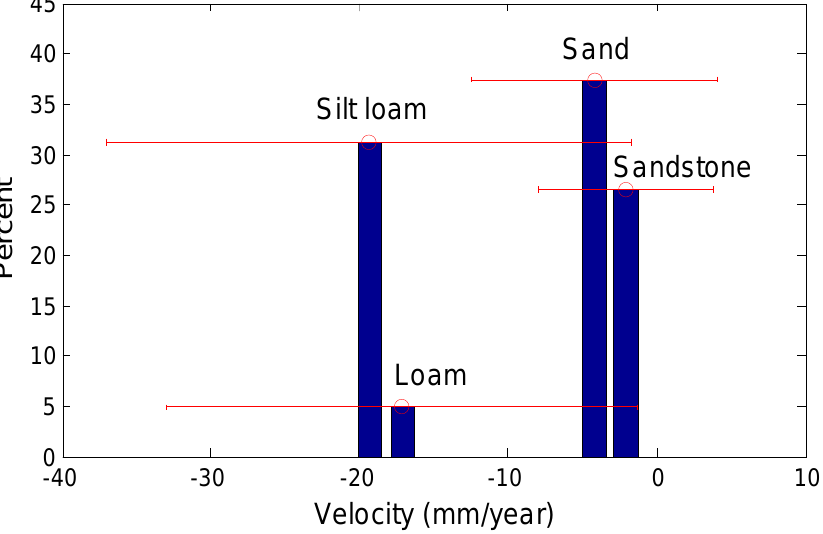
Figure 8. Relation of the geological class and subsidence trend. Table 2. Relation of urbanization (through groundwater extraction and urban growth factors) and subsidence with silt loam